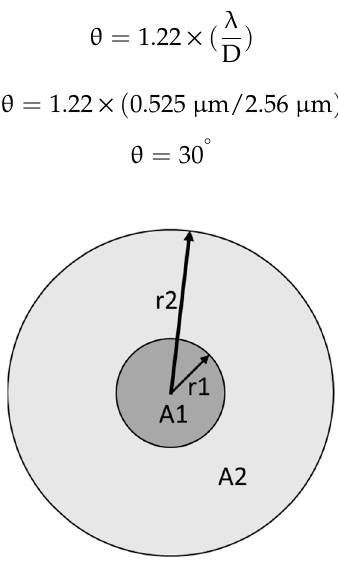
Figure 20. The angular distribution radius of the Cone LED beam r 2 and the CPC output beam radius r 1 .